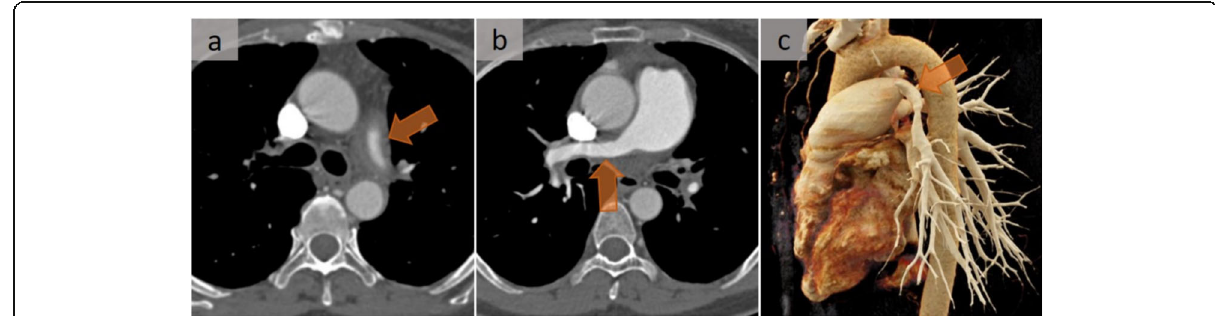
Fig. 8 Post-mediastinitis pulmonary hypertension. Pulmonary artery stenosis in a case of fibrosing mediastinitis with pulmonary hypertension. Contrast-enhanced CT scan demonstrated at two successive levels ( a , b ), with a soft tissue attenuation mass diffusely infiltrating the mediastinum with encasement and narrowing of the pulmonary arteries (arrows). The stenosis of the right pulmonary artery is perfectly observed on the oblique 3D rendering view ( c ) (arrow). This mass had no significant metabolic uptake on 18F-FDG PET/CT (not shown). Note also the stenosed upper pulmonary veins